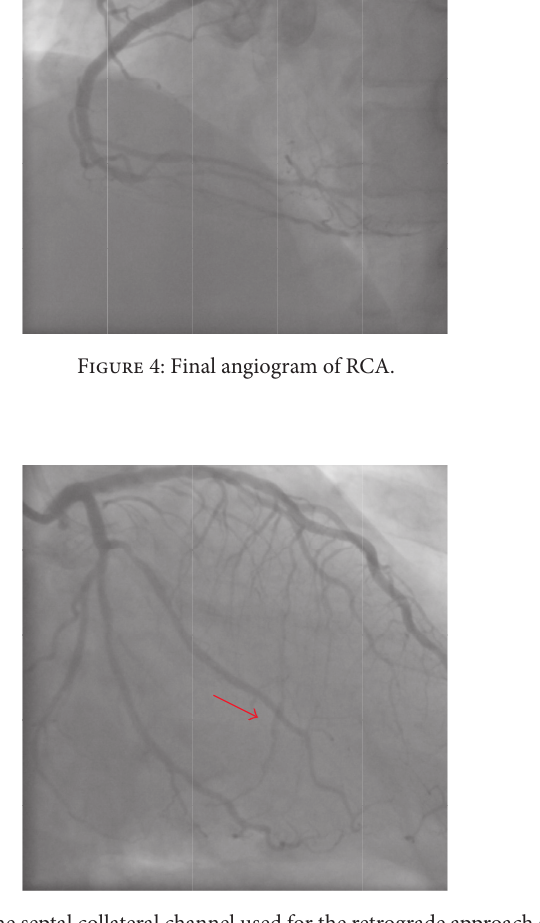
Figure 5: A contrast “stain” surrounding the septal collateral channel used for the retrograde approach at the end of procedure (red